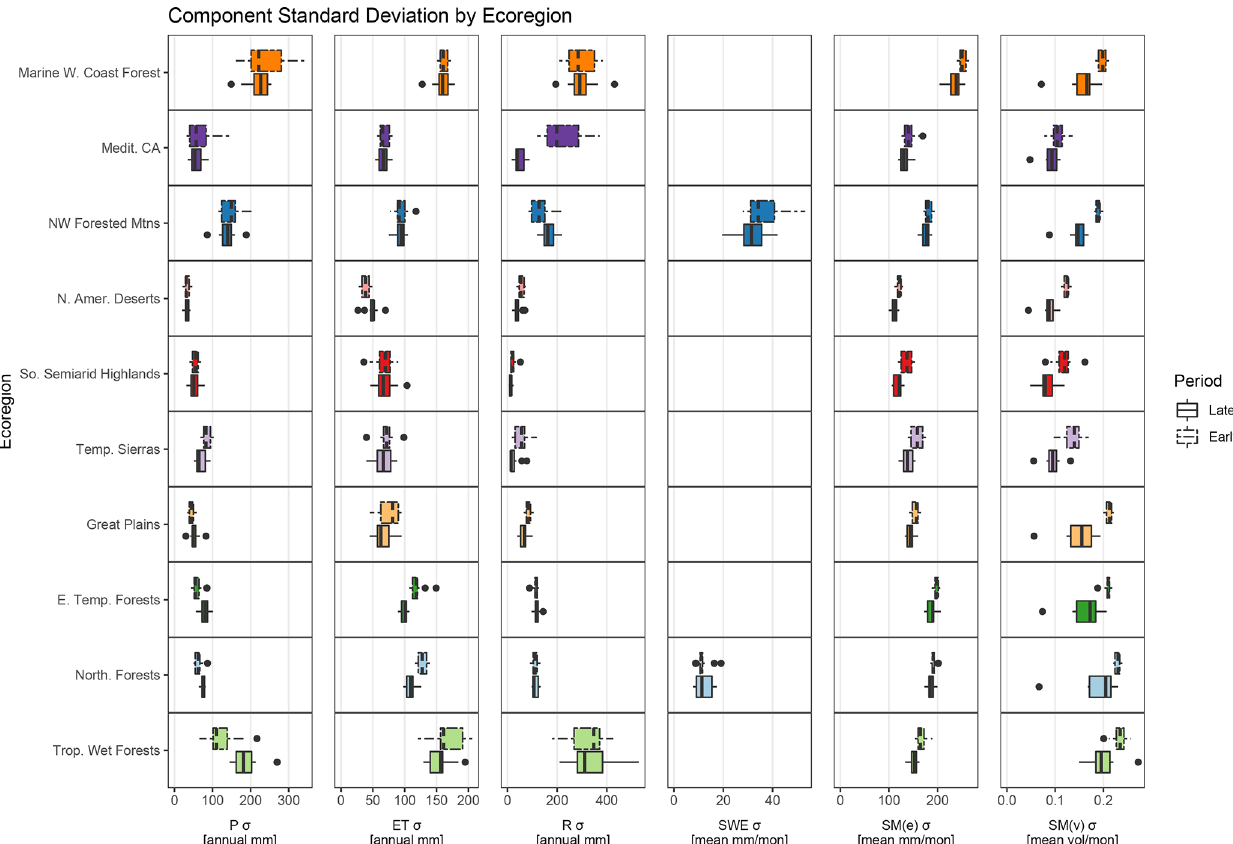
Figure B1. Box plots of annual standard deviation ( σ ) between component estimates at 10 ecoregions. σ distributions are subdivided into two periods, namely 1985–1999 and 2000–2014. Box lower limits, midlines, and upper limits represent the 25th, 50th (median), and 75th percentiles, respectively, of the associated data. Whiskers represent 1.5 times the interquartile range. Box colors denote ecoregions and correspond to map colors in Fig. 1. Components displayed are precipitation ( P ), evapotranspiration (ET), runoff ( R ), snow water equivalent (SWE), soil moisture in units of equivalent water depth (SM( e )), and soil moisture in units of volumetric water content (SM( v